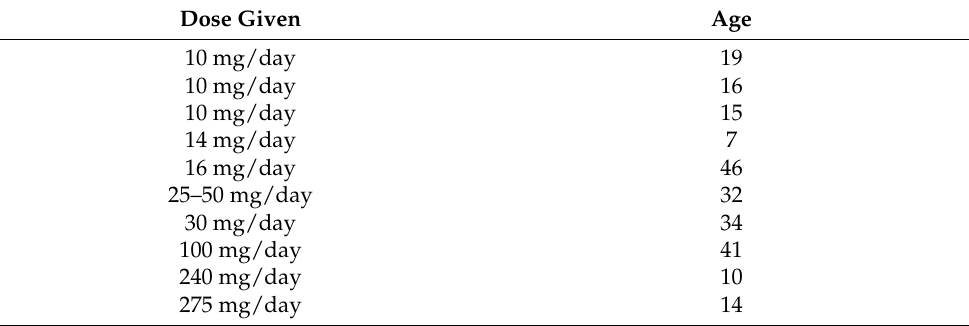
Table 3. Daily doses of CBD (mg/day) and ages of individuals with FXS (n = 10). Dose Given Age 10 mg/day 19 10 mg/day 16 10 mg/day 15 14 mg/day 7 16 mg/day 46 25–50 mg/day 32 30 mg/day 34 100 mg/day 41 240 mg/day 10 275 mg/day